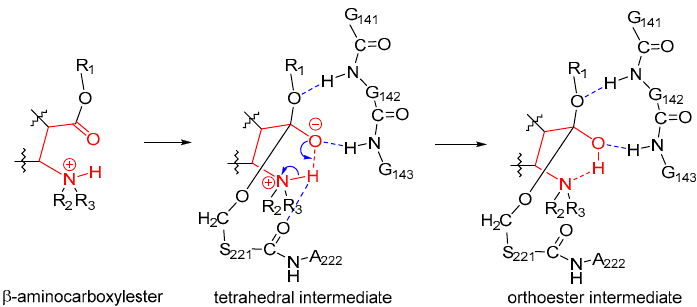
Figure 7. Proposed mechanism of formation of orthoester intermediates during the hCES1-catalyzed hydrolysis of substrates bearing β -aminocarboxylester structure. The intramolecular six-membered ring scaffold (shown in red) is chemically stable. Only the orthoester intermediate in the acylation stage is shown here for example.